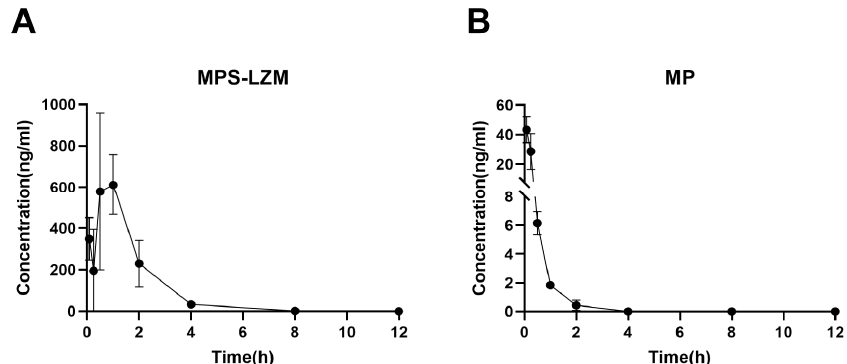
Figure 7. Renal accumulation of of ( A ) MPS–LZM and ( B ) MP after intravenous administration. Data represent mean ± SD ( n = 6). Table 2. Pharmacokinetic parameters of MP and MPS–LZM in kidneys after a single intravenous injection.